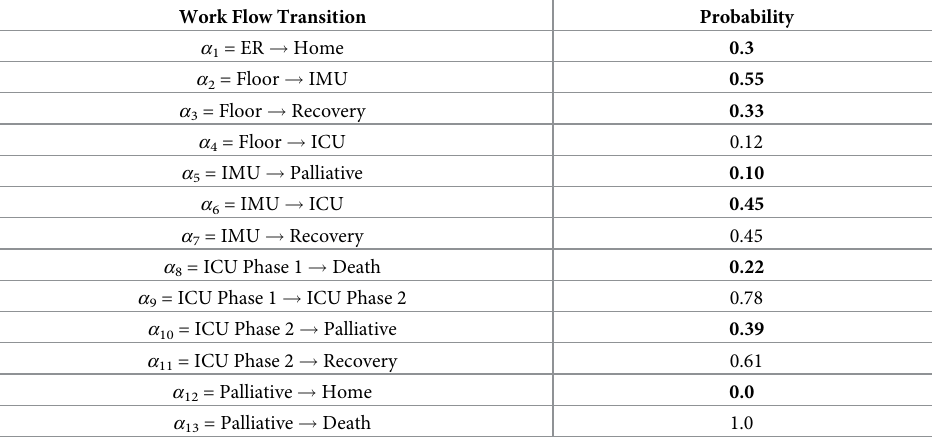
Table 1. Probability of transition for the patient in reference to the workflow of Fig 1.